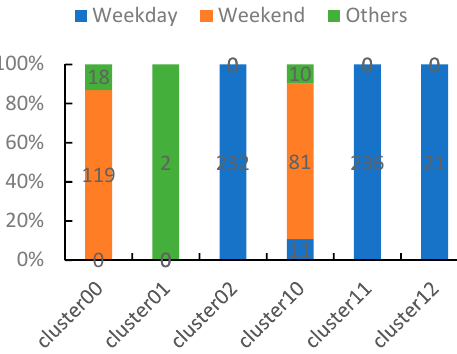
Figure 9. Weekday distribution of the original Pearson results.